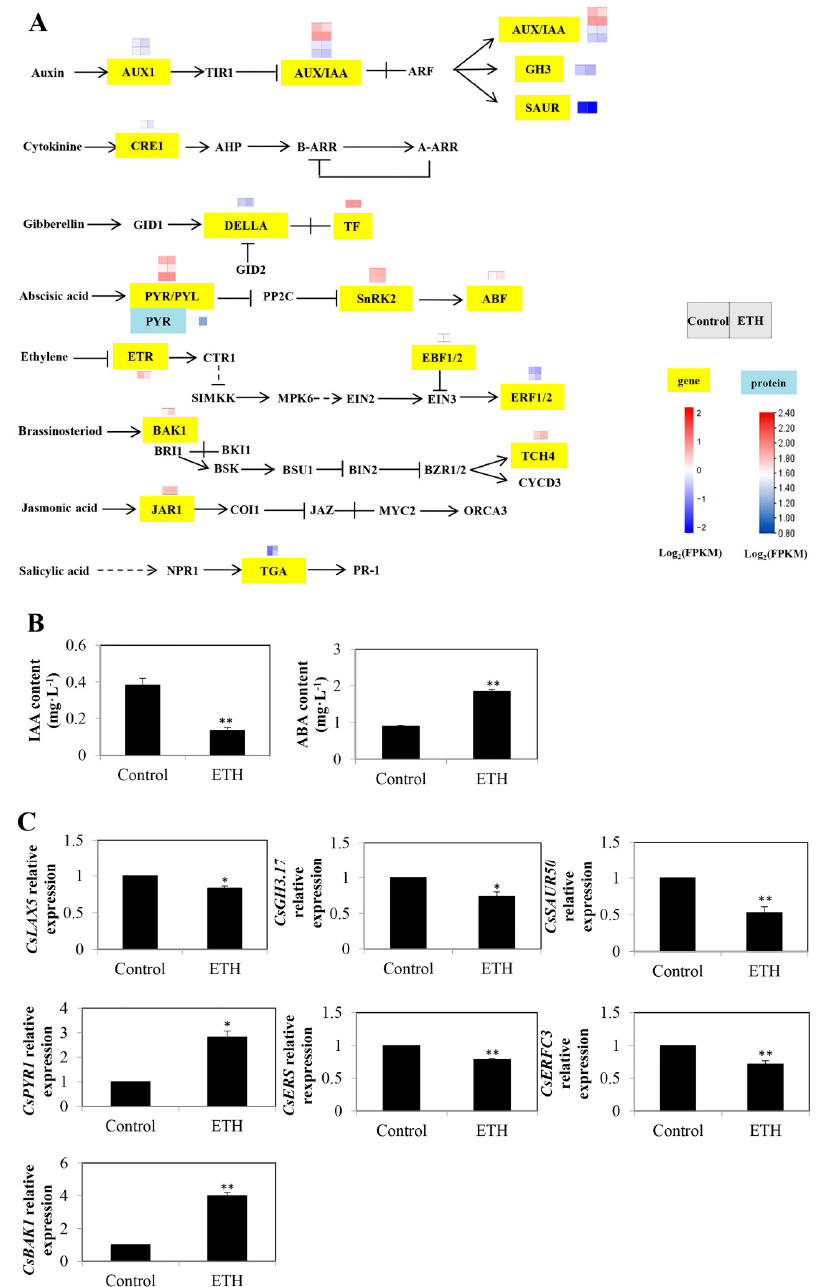
Figure 7. Identification and validation of key DEGs in plant hormone signal transduction during adventitious root development in cucumber. ( A ) Expression patterns of genes and proteins for plant hormone signal transduction during adventitious root development in cucumber. Annotations of genes and proteins are available in Supplementary Table S10. Black characters with yellow background are genes, whereas black characters with blue background are proteins. The two squares under the names of genes or proteins indicate the change in abundance of the control and ETH. A red square means up-regulation, whereas a blue square means down-regulation. ( B ) The contents of IAA and ABA during adventitious root development in cucumber. ( C ) Quantitative real-time PCR analysis of the expression profiles of 7 genes related to plant hormone signal transduction during adventitious root development in cucumber. Asterisk (*) and double asterisk (**) indicate the significance at p < 0.05 and p < 0.01, respectively. The bar represents the value of standard error. Values represent the mean ± SE of three replicates. Each experiment was repeated three times